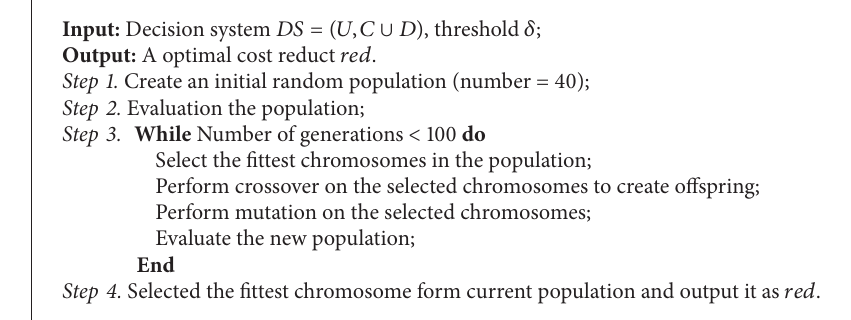
Algorithm 2: Genetic algorithm for attribute reduction based on cost minimum criterion.